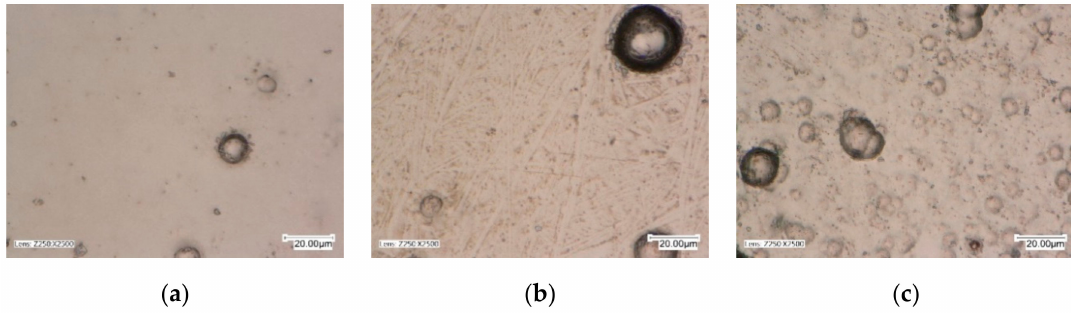
Figure 2. Morphology of Ni-P and Ni-P / Si 3 N 4 layers; ( a )—Ni-P, ( b )—Ni-P / Si 3 N 4 (2 g / dm 3 ), ( c )—Ni-P / Si 3 N 4 (5 g / dm 3